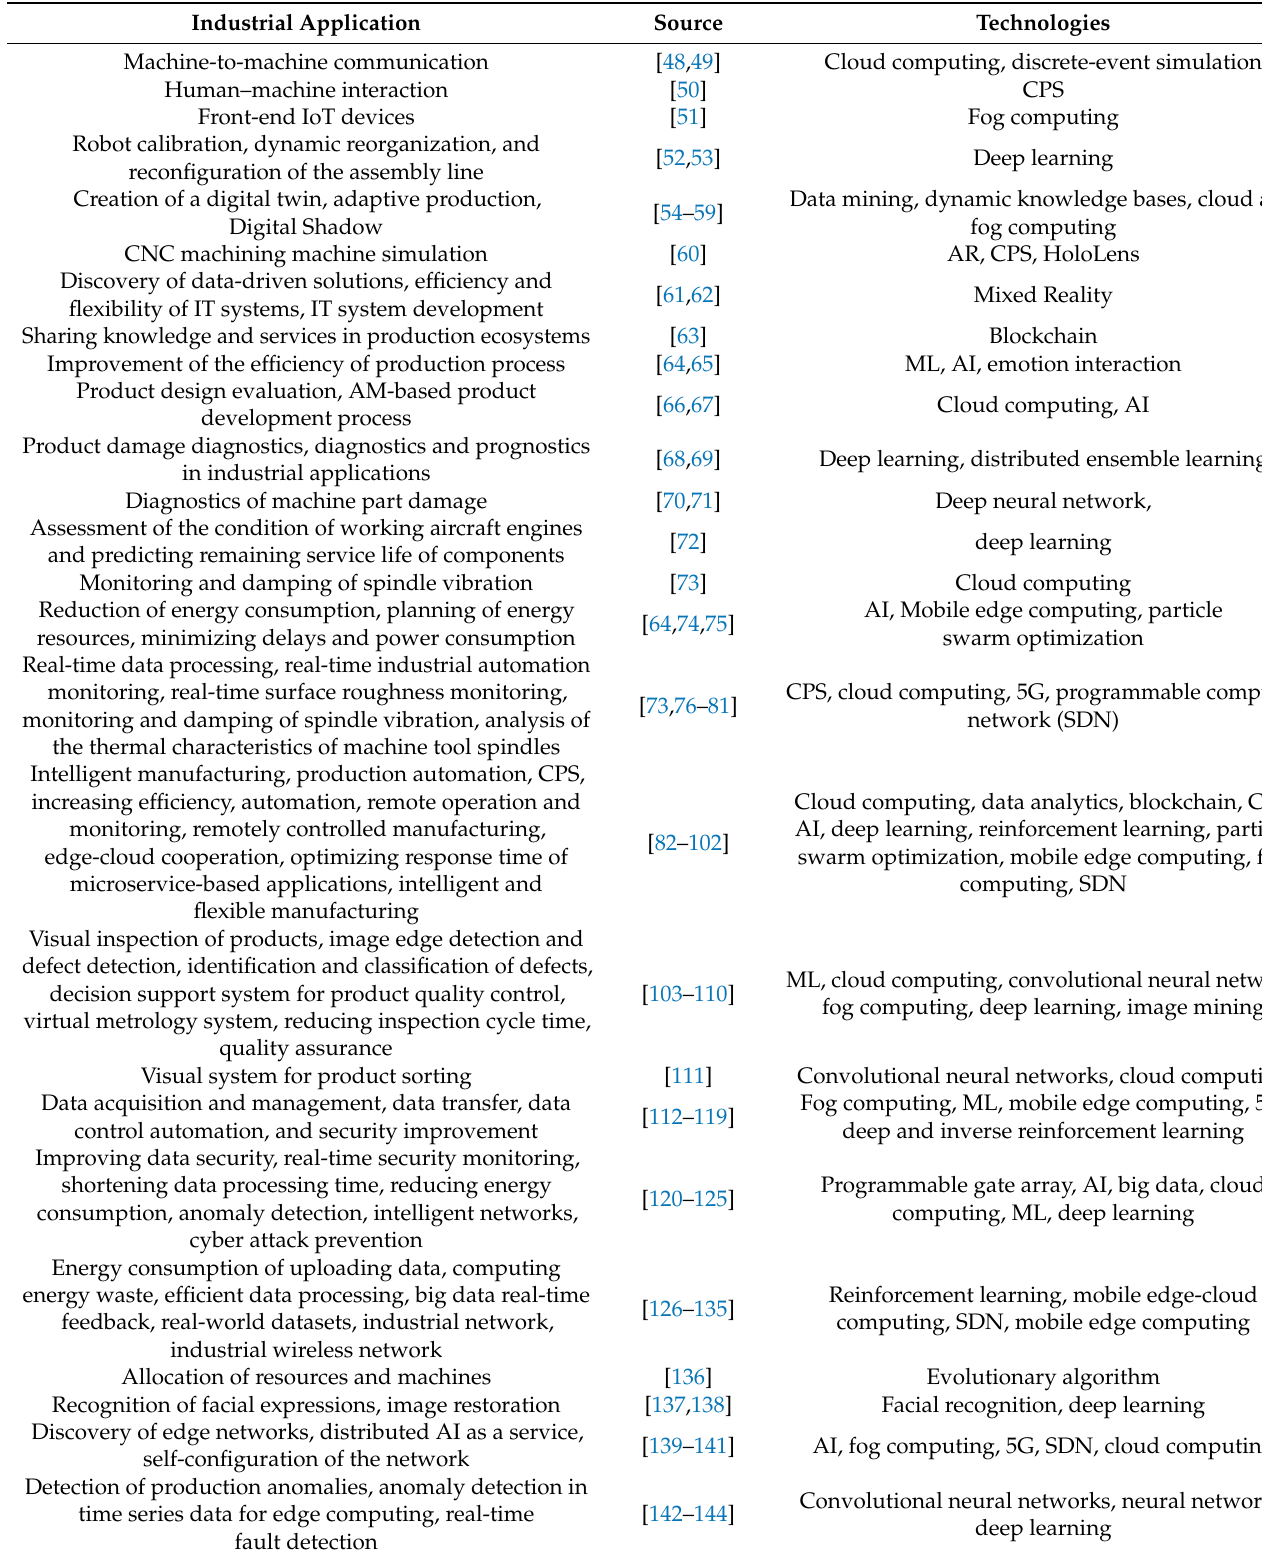
Table 7. EC industrial application and related